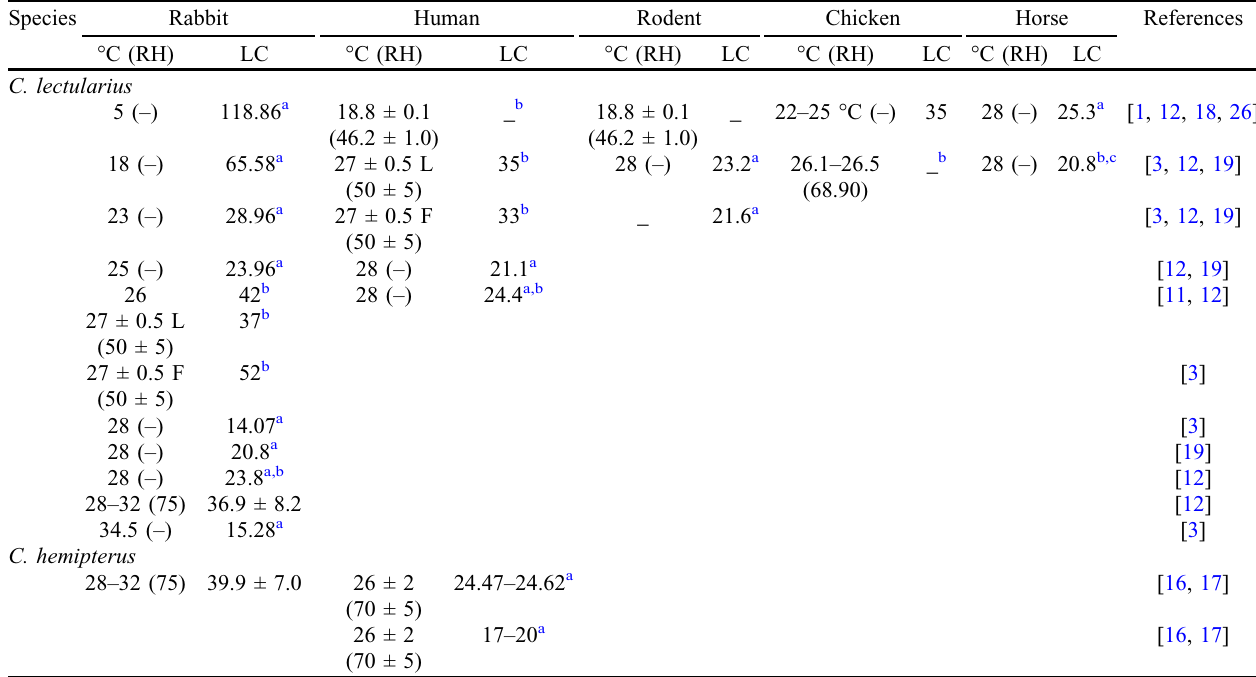
a without egg, b artificial feeding, c without egg and instar V, (cid:2) C: temperature, RH: relative humidity (%), LC: life-cycle, L: laboratory, F: